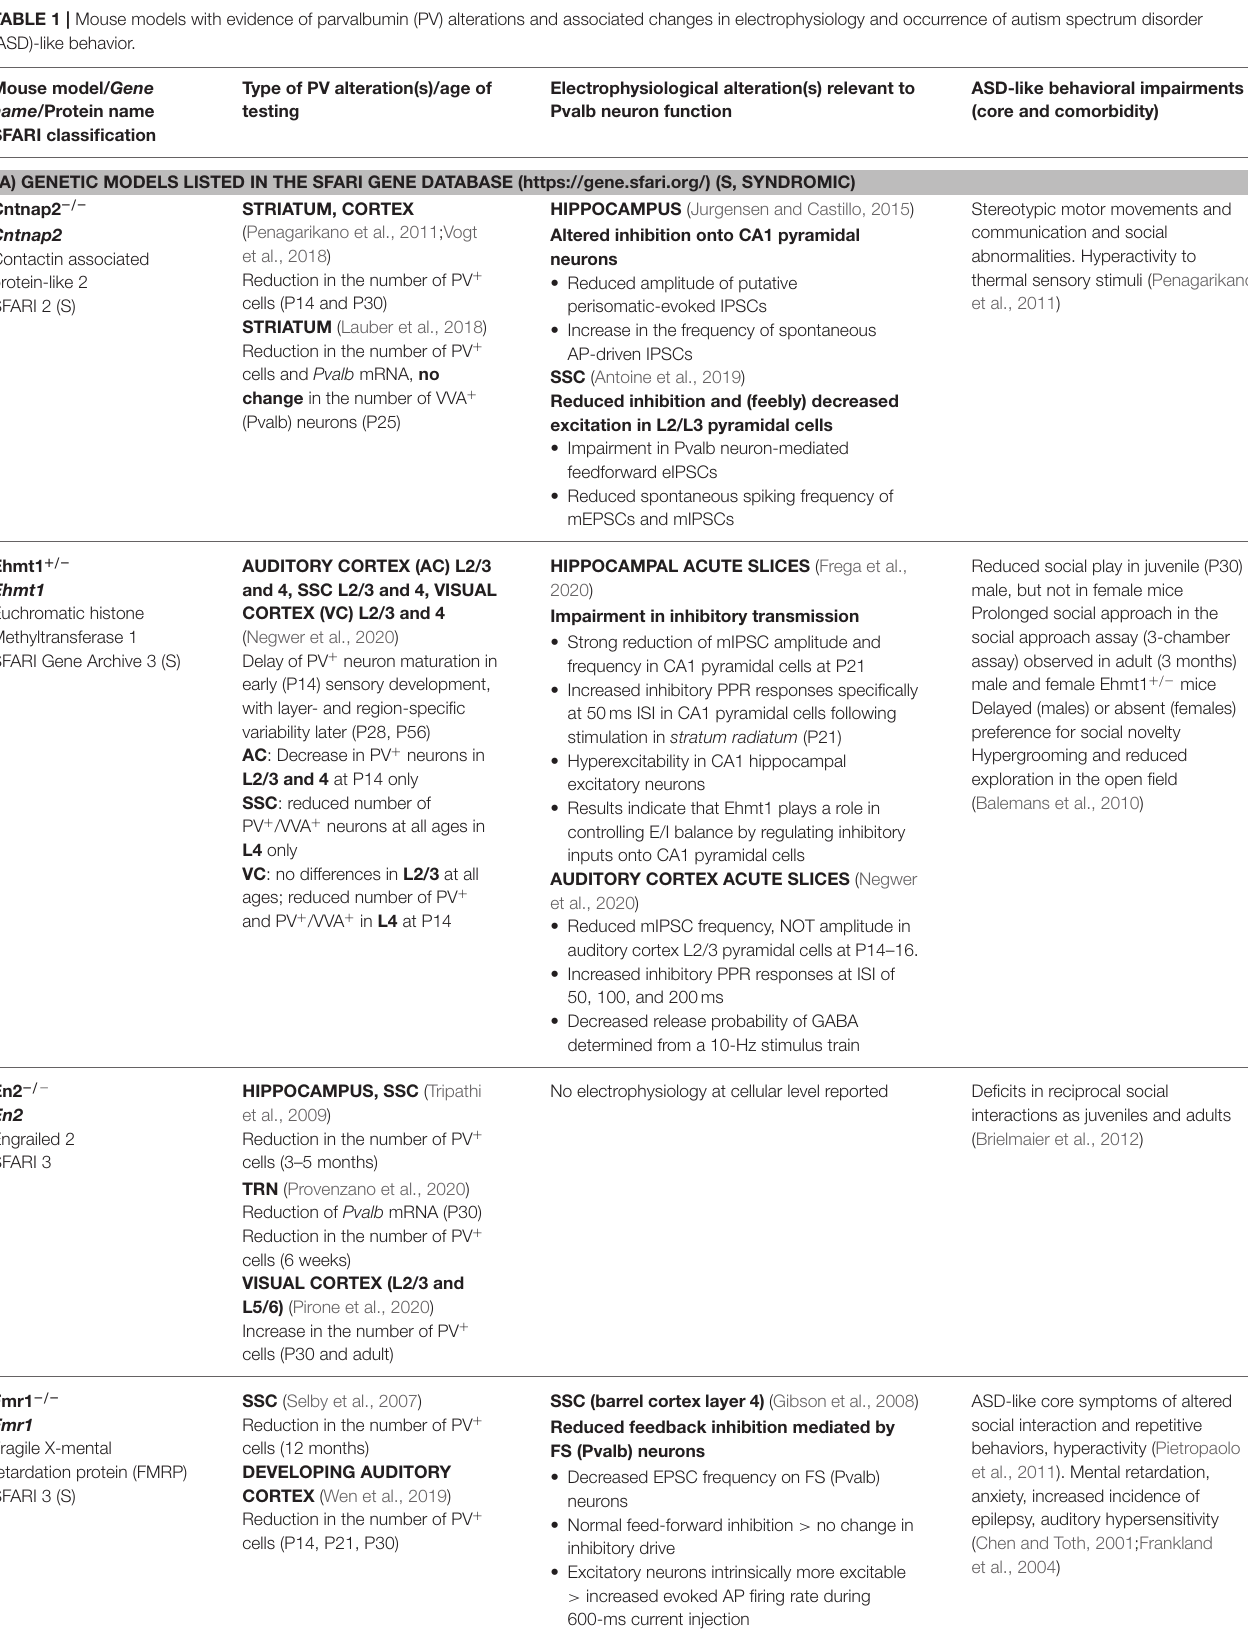
TABLE 1 | Mouse models with evidence of parvalbumin (PV) alterations and associated changes in electrophysiology and occurrence of autism spectrum disorder (ASD)-like